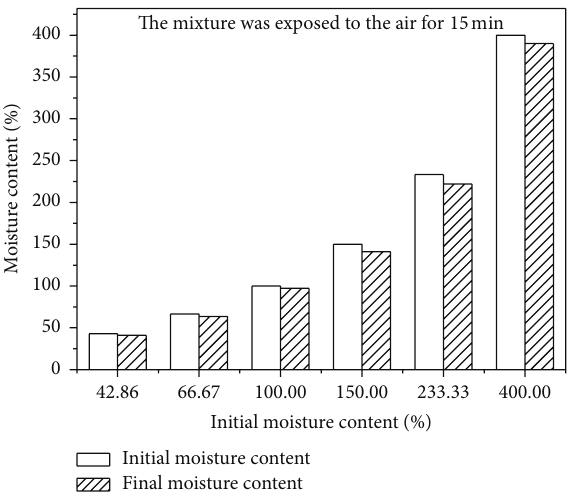
Figure 2: Moisture content before and after preliminary test 1.